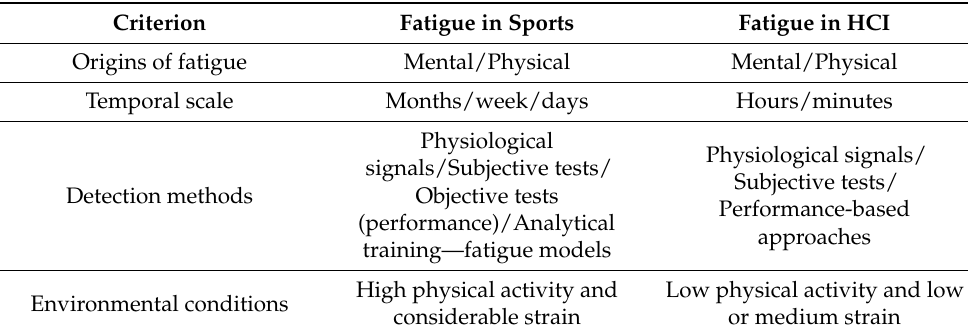
Table 2. Comparison of fatigue in sports and